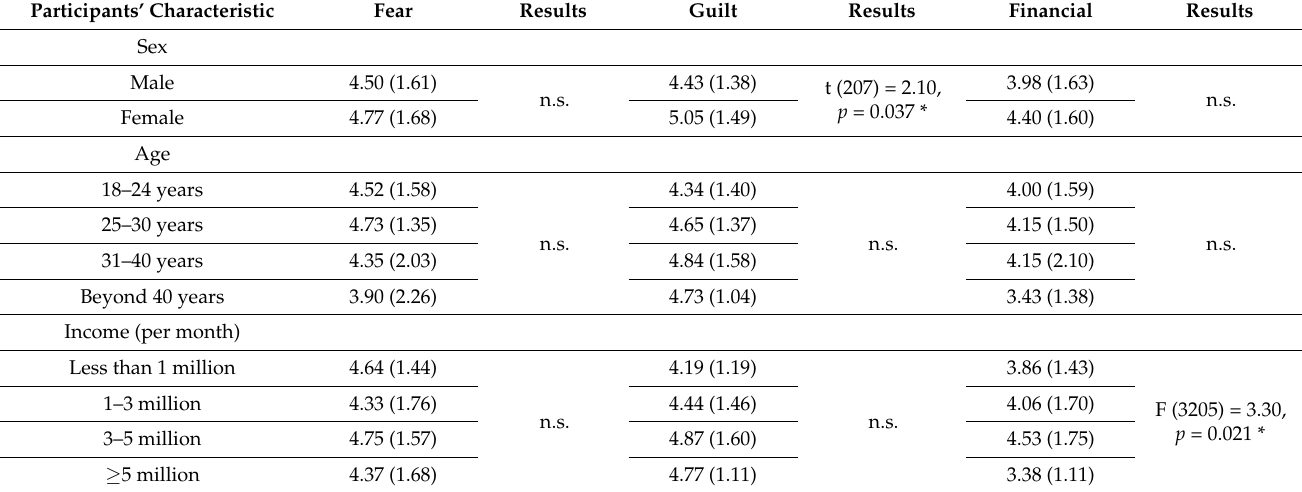
Table 3. Student’s T-test and one-way ANOVA among participant characteristics in the message approach. Participants’